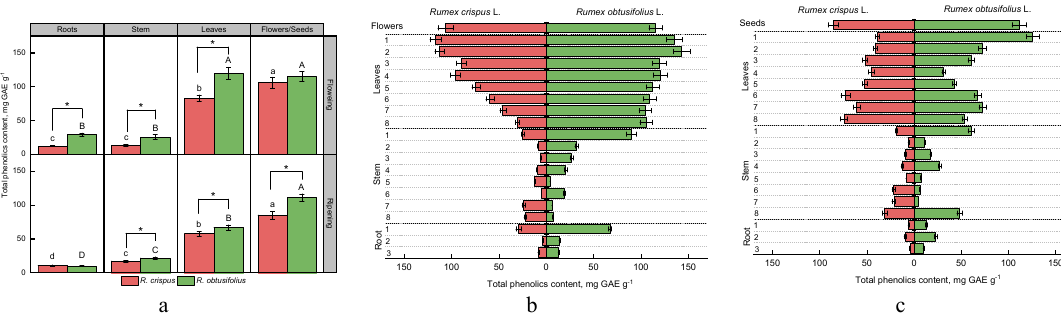
Figure 4. The content of phenolic compounds in different parts of plants R. crispus and R. obtusifolius at flowering and fruiting stages ( a ), and vertical distribution of phenolic compounds at flowering stage ( b ) and at fruiting stage ( c ). Different lower case letters indicate significant differences among plant parts of R. crispus ; upper case letters indicate significant differences among plant parts of R. obtusifolius ( p ≤ 0.05); asterisk * indicates significant differences among sorrel species ( p ≤ 0.05) based on post hoc Tukey’s tests separately for each growth stage.